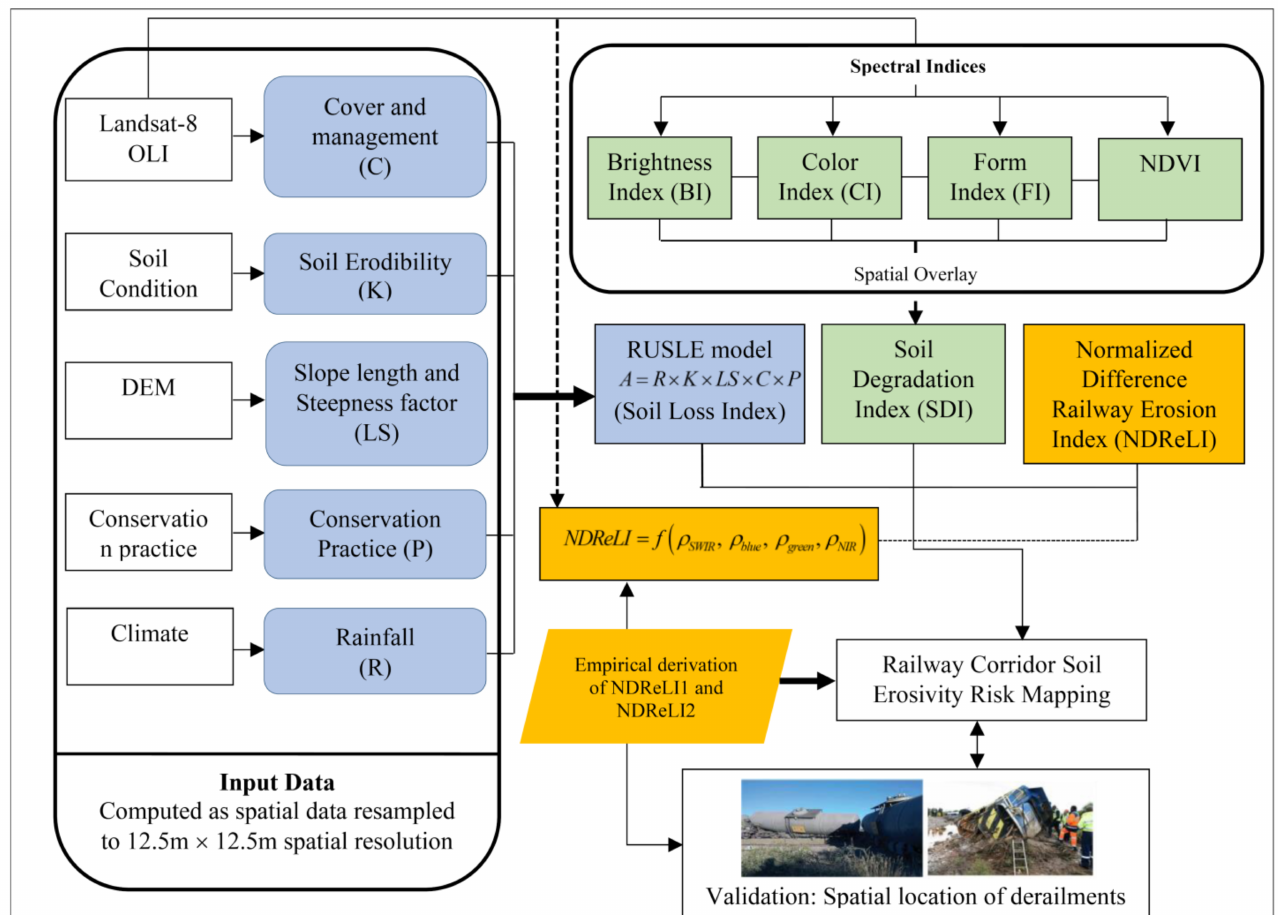
Figure 3. Schematic flow for the prediction of soil erosion susceptibility in railway corridors using RUSLE, SDI and